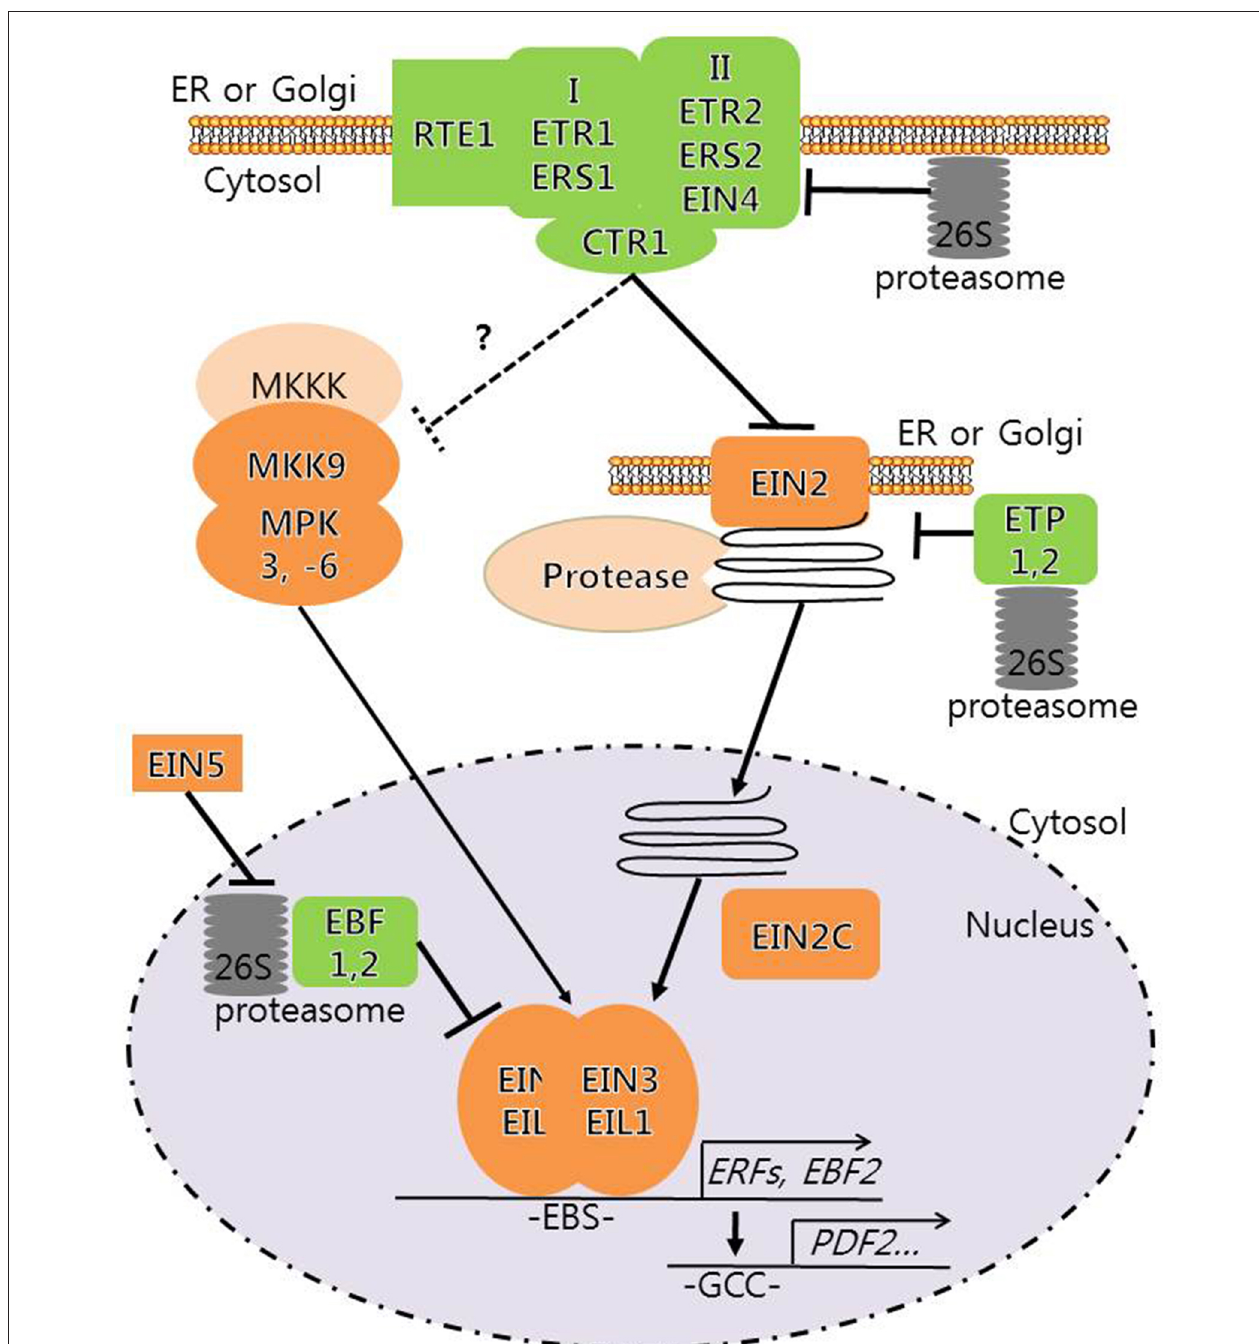
includes proteasome-dependent degradation of ETR2 protein. EIN2C is cleaved from EIN2 at ER or Golgi and moves into the nucleus in the presence of C 2 H 4 . The nuclear EIN2C then activates EIN3 dependent gene transcription through a unknown mechanism. Concurrently, MKK9–MPK3,6 cascade is activated in the presence of C 2 H 4 . Both EIN2 and EIN3 protein stability is respectively under the regulation of ETP1, ETP2 and EBF1, EBF2 F-box proteins in E3 ligase complexes that are coupled with 26S proteasome activity. EIN3 accumulation in the nucleus initiates the early transcription and some of these early gene products trigger the secondary transcription. EIN5 indirectly regulates EIN3 stability through mRNA regulation of